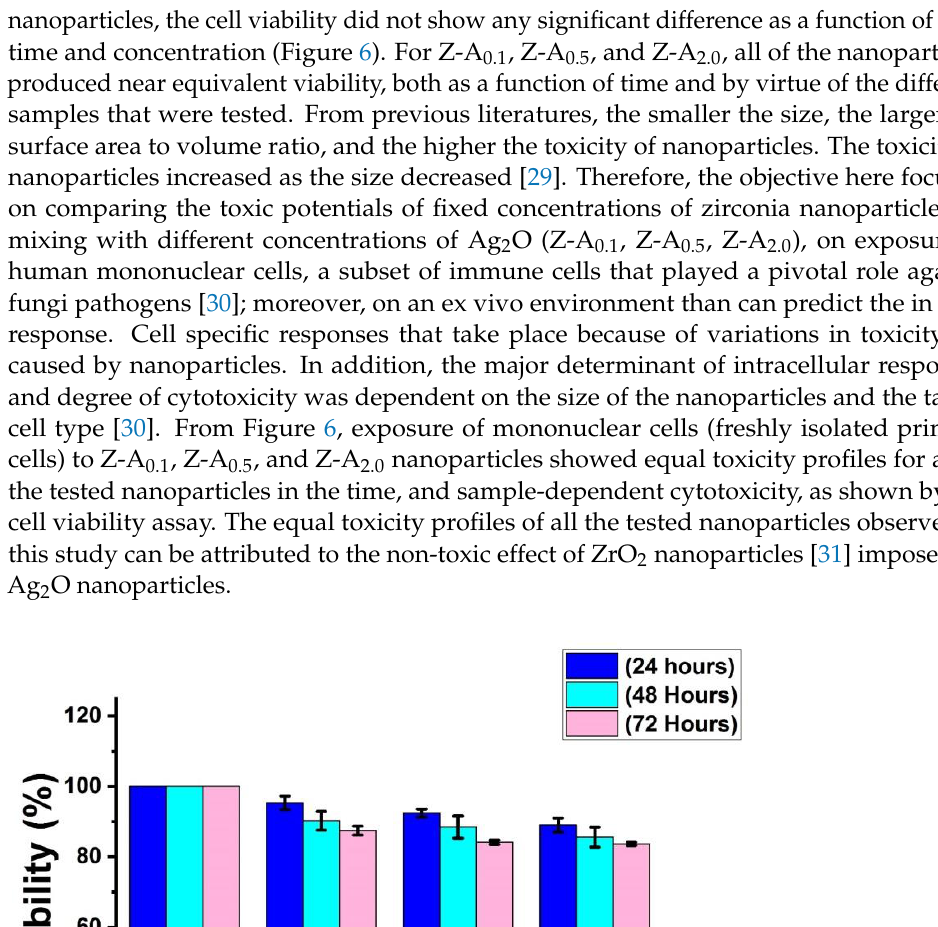
Table 2. Comparison of the zone of inhibition (mm) formed by different reported materials against some Candida spp. with the synthesized Z-A 2.0 nanoparticles.